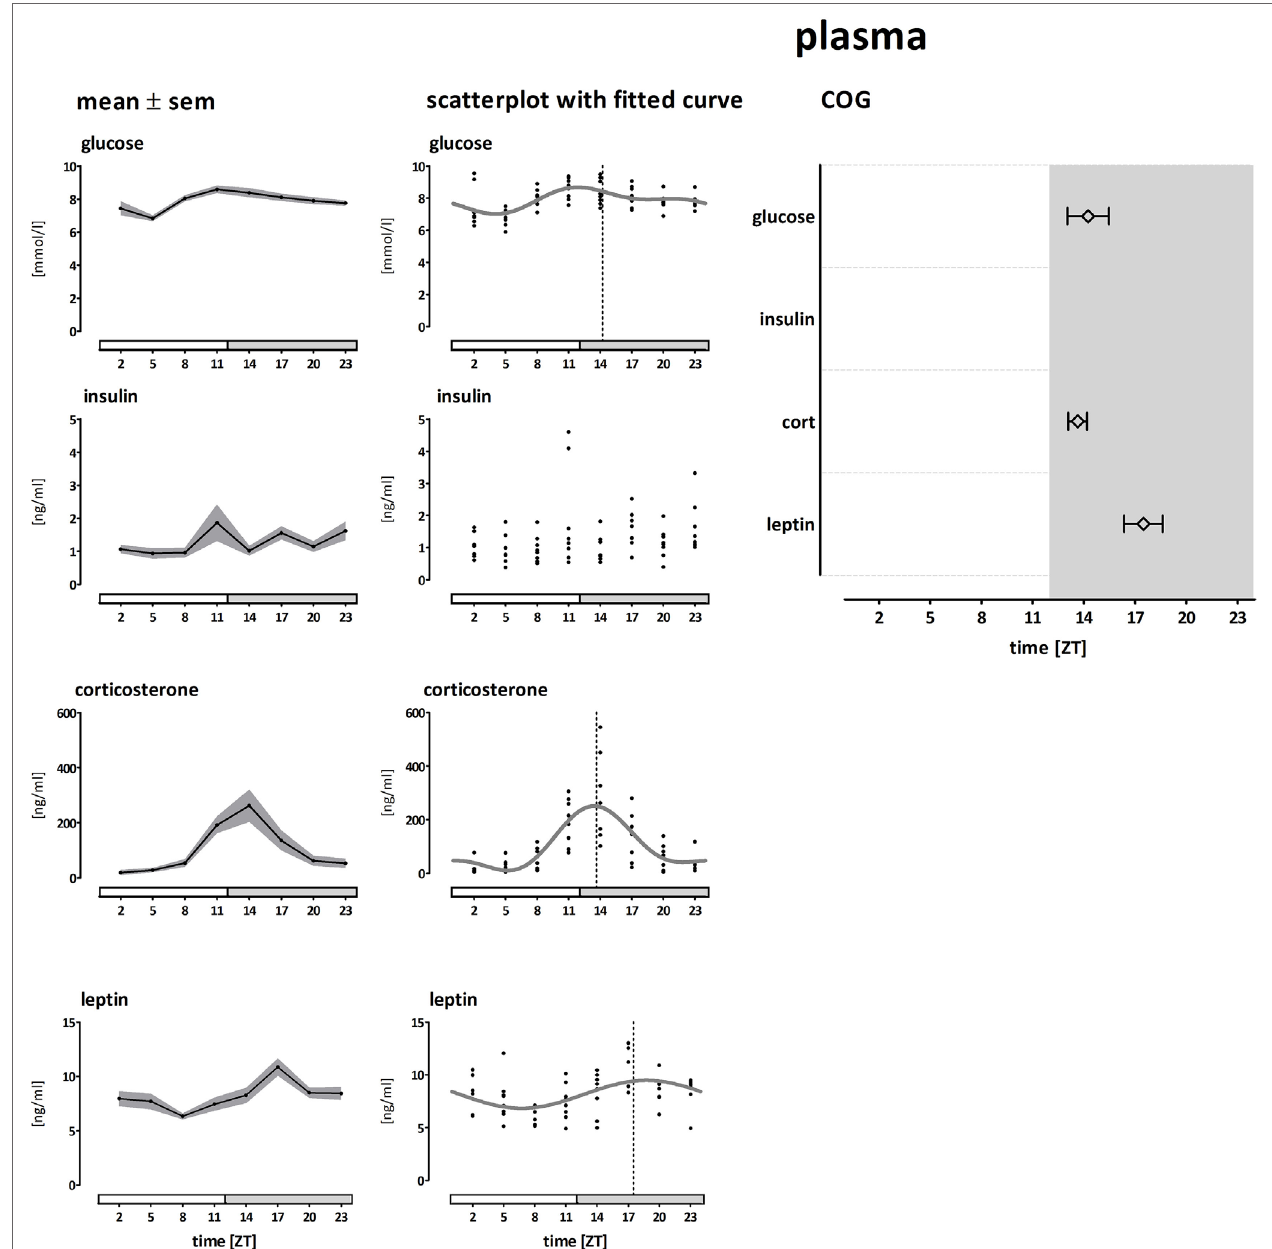
FigUre 4 | Plasma concentrations of glucose, insulin, corticosterone, and leptin. Left panel shows the mean ( ± SEM) plasma concentrations. The middle panel shows the individual data points and Circwave curves, the dotted line indicates the Center of Gravity (COG). The right panel shows the COG ( ± SD). Absence of the Circwave curve and the COG line indicates absence of significant rhythmicity as analyzed by Circwave. Gray bars indicate the dark phase (ZT